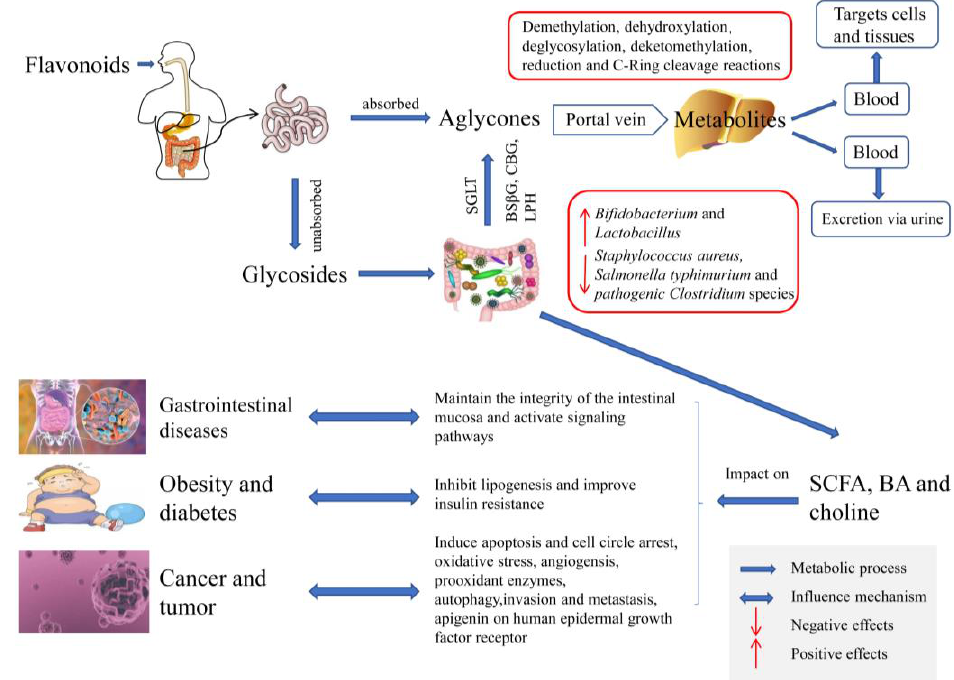
Figure 1. The metabolic mechanisms of flavonoids by gut microbiota and impacts on health. SGLT: Sodium-dependent glucose transporters; BS β G: Broad-specific β -glucosidase; CBG: Cytosolic β -glucosidase; LPH: Lactosephlorizin hydrolase; SCFAs: Short-chain fatty acids; BA: Bile acids. 4.1.2. The Role of Gut Microbiota Metabolism and Biotransformation on